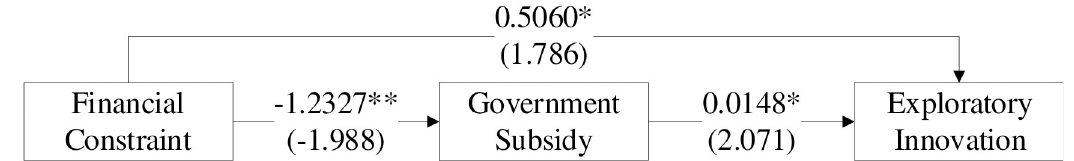
Fig 3. Main results of subsample with an exploratory innovation strategy. [1] t statistics in parentheses. [2] � , p < 0.1; �� , p < 0.05; ��� , p <